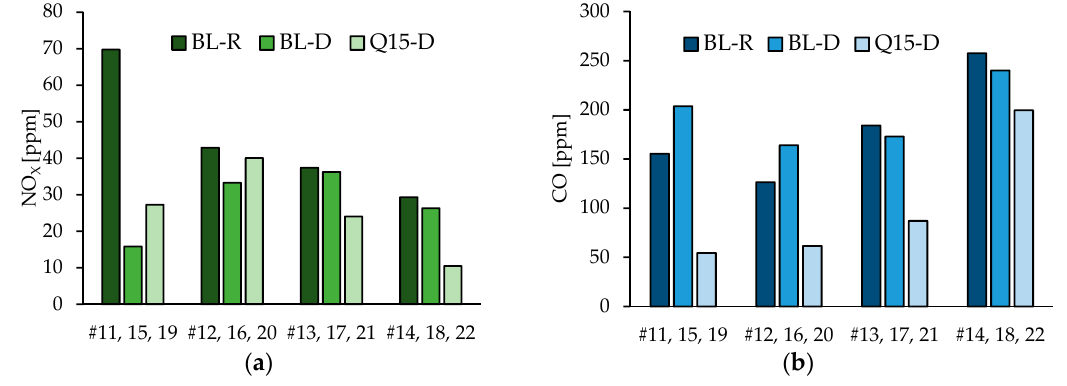
Figure 11. ( a ) NO X and ( b ) CO emissions of Cases 11–22, shown Figure 9.